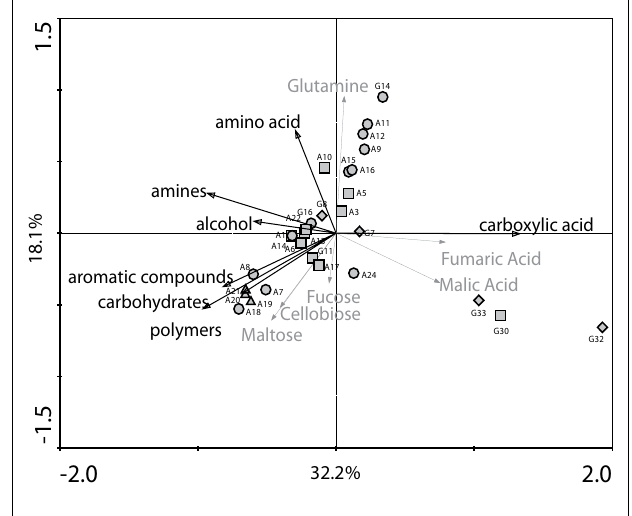
FIGURE 1 | Principal components analysis showing the metabolic diversity of 29 denitrifying bacterial strains, as determined by metabolic profiles using BIOLOGAN plates under denitrifying conditions. For each strain, the label corresponds to the code provided in Table 1 . Symbols correspond to the phylogenetic groups of bacterial strains studied. Squares: α -proteobacteria; circles: γ -proteobacteria; diamonds: β -proteobacteria; triangles: Bacilli. Black arrows indicate the classes of carbon substrates found in the BIOLOG; gray arrows indicate the six selected individual carbons substrates used in the microcosm